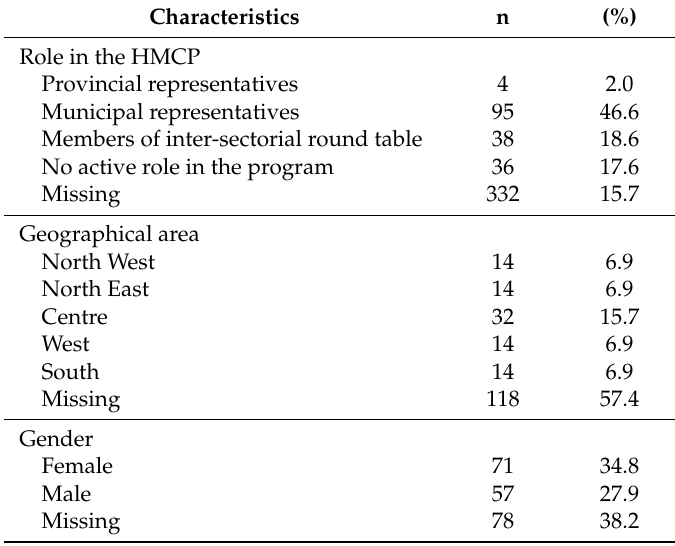
Table 2. Characteristics of respondents of the electronic survey (n = 206).